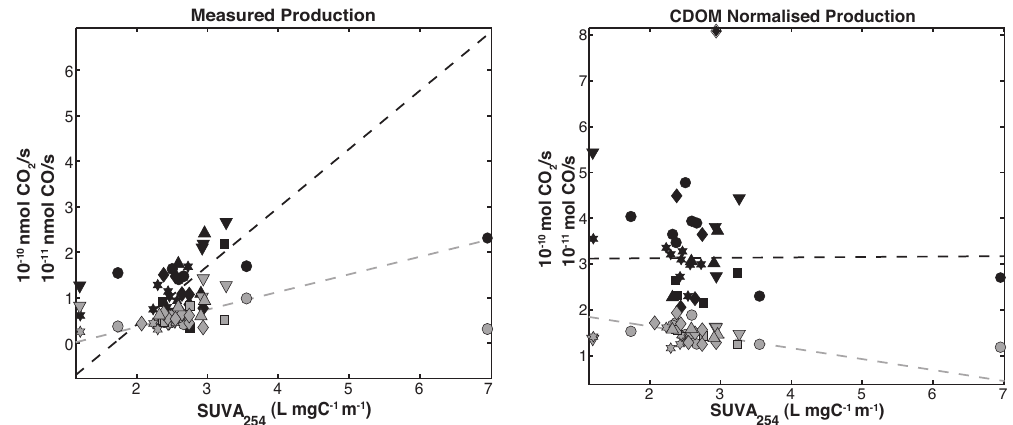
Fig. 7. Measured production and CDOM normalized production with respect to the specific UV absorbance (254nm) of the sample. Black symbols represent CO 2 ( R 2 = 0 . 30 measured, 0.46 normalized, robust fit down-weighting outliers) and grey symbols represent CO ( R 2 = 0 . 52 measured, 0.08 normalized). Symbol key: circle – Altamaha high tide, pointing down triangle – Altamaha low tide, star – Sapelo